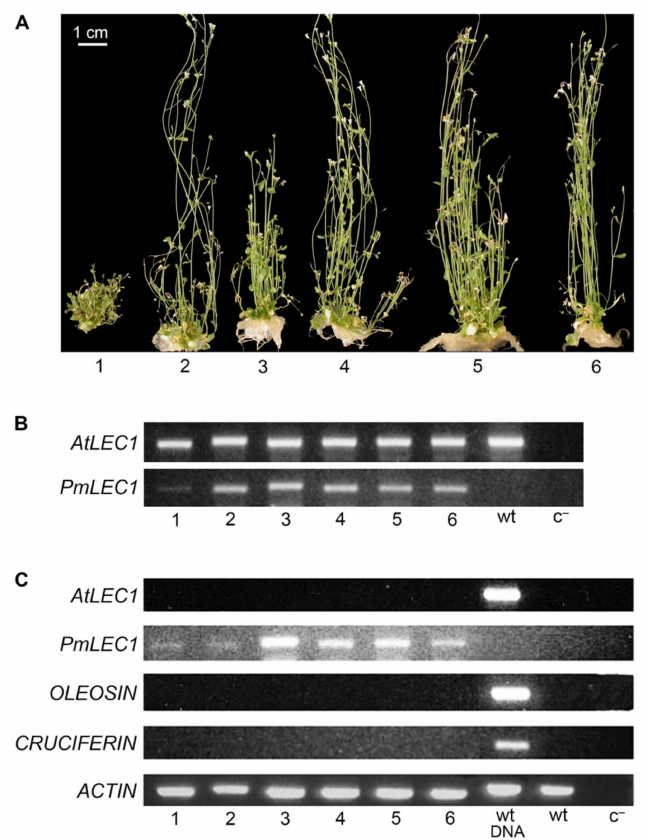
Figure 6. Morphology, genotype analysis and gene expression profiles of individual T2 variants derived from one wt PmLEC1 T1 progenitor line. ( A ) Bushy phenotypes of T2 seedlings derived from one wt PmLEC1 T1 progenitor line. ( B ) PCR analysis of T2 variants using AtLEC1 - and PmLEC1 -specific primers (top and bottom panel, respectively) to confirm genotype and the presence of transgenes. Lanes 1 to 6 represent DNA from plants shown in panel A; wt, DNA from a wild type Arabidopsis plant (positive control); c − , PCR without DNA template (negative control); ( C ) RT-PCR analysis of gene expression. Each reaction comprised 0.1 µ g DNase I-treated total RNA isolated from the indicated plant material. The analyzed genes are provided to the left of the corresponding panels. Lanes 1 to 6 represent transcripts from the plants shown in panel A; wt DNA, genomic DNA from a wild type Arabidopsis plant (DNA control); wt, RNA from a wild type Arabidopsis plant (control, non-transgenic); c − , reverse transcription without RNA, followed by PCR (negative control). Only vegetative tissues, stems and leaves were utilized for molecular analyses. All plants contained endogenous AtLEC1 and the PmLEC1 transgene (Figure 6B). While all plants expressed the PmLEC1 transgene within mature tissues, none expressed AtLEC1 or